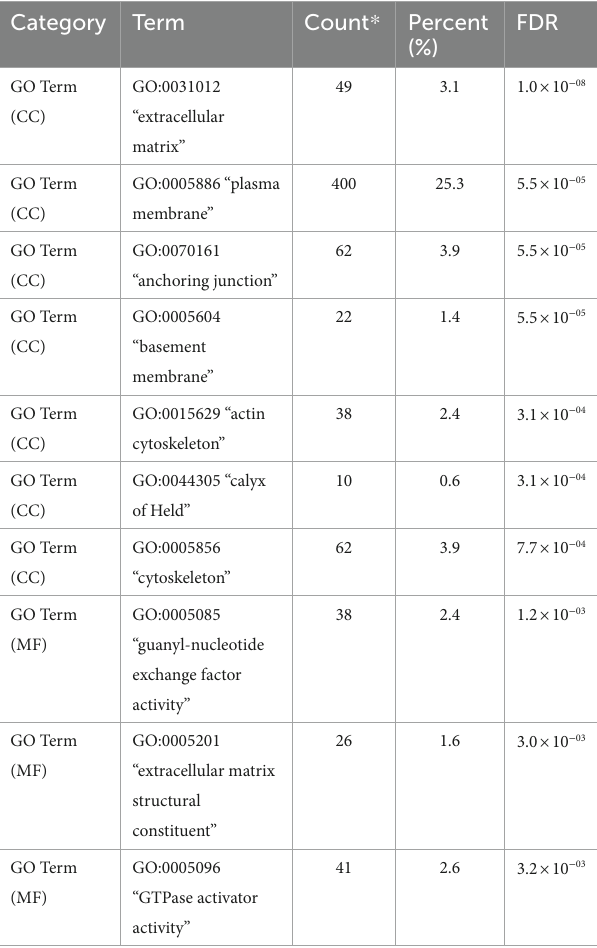
TABLE 6 Top-10 enriched functional annotations for 5hmC sites differentiated between BD case and sib pairs for NSC cell lines ( p < 0.05; localized to 1,582